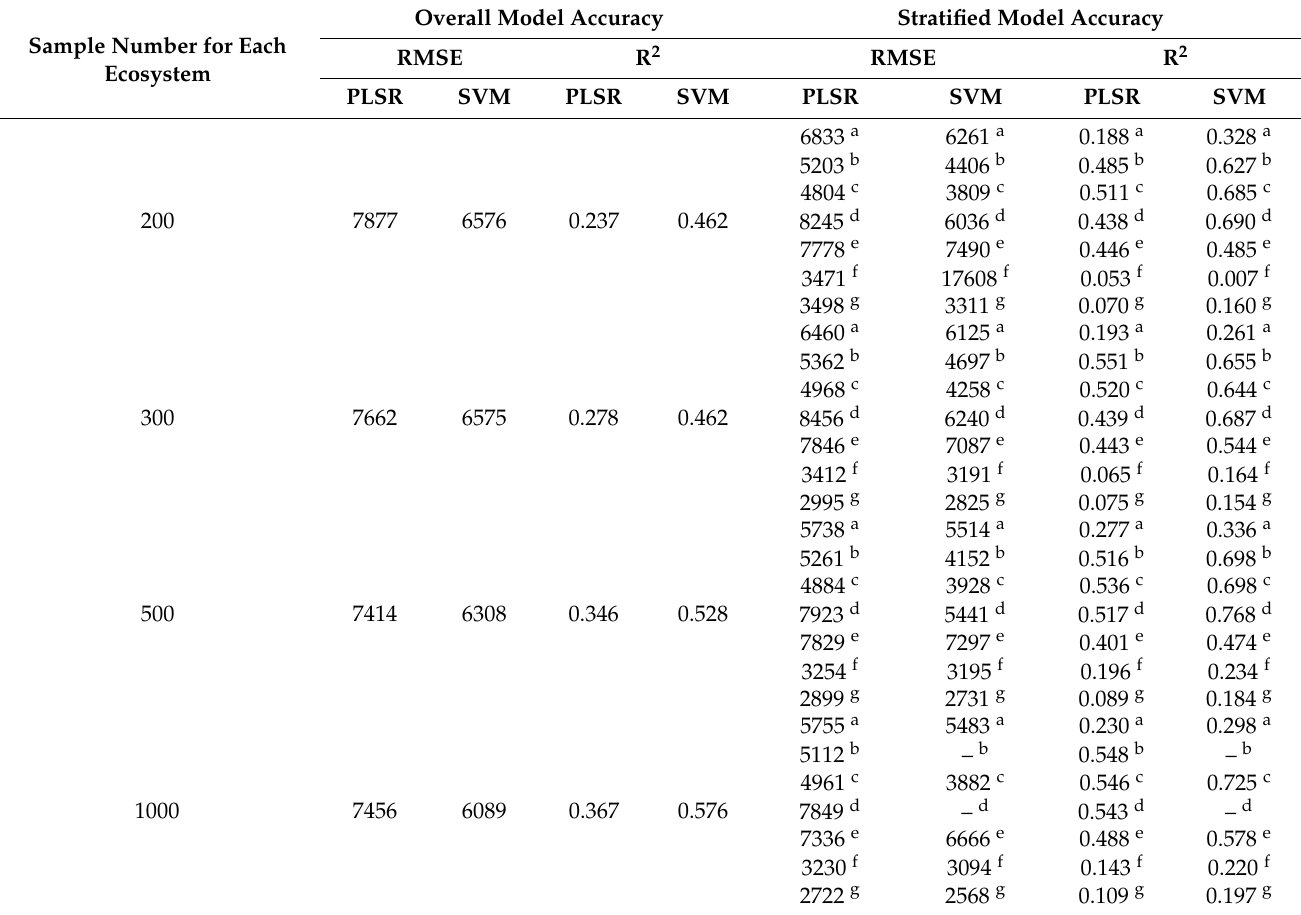
Table 1. The model estimated results of the different sample points for each ecosystem.